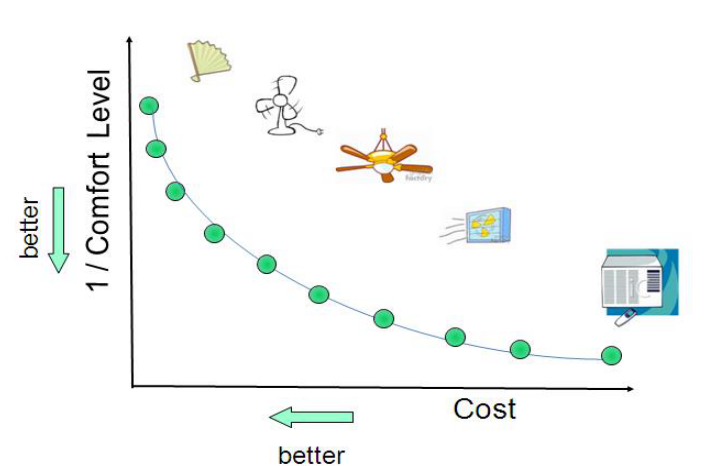
Figure 1. Trade off solutions for cooling system buying DM